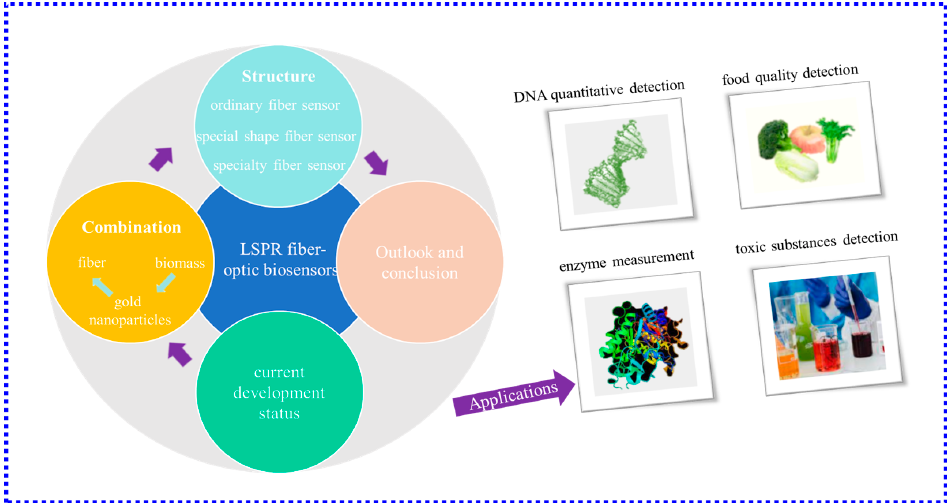
Figure 1. Schematic diagram of the main content of this review.